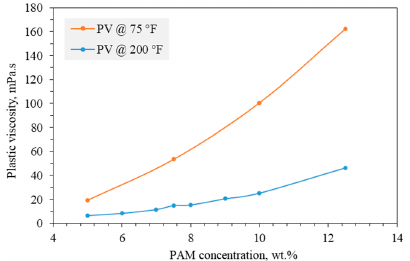
Figure 3. Impact of PAM concentration on PV of the PAM ‐ based drilling fluid at 75 °F and 200 °F.